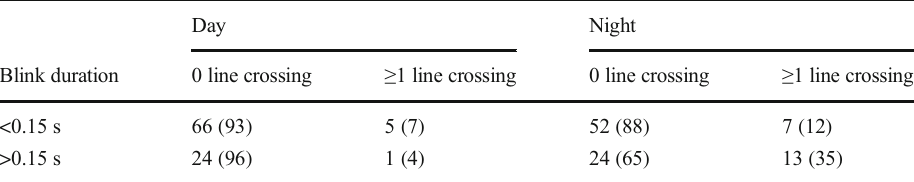
Table 4 Number of segments with at least one line crossing during day and night at different levels of blink duration. Percentages of observations distributed per blink duration group, separated for day/night